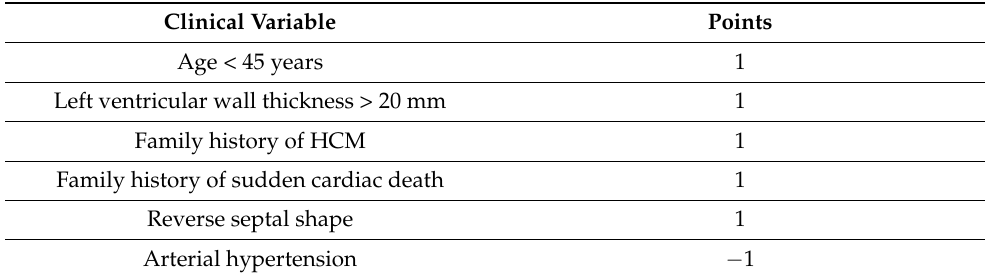
Table 3. Mayo HCM Genotype Predictor Score